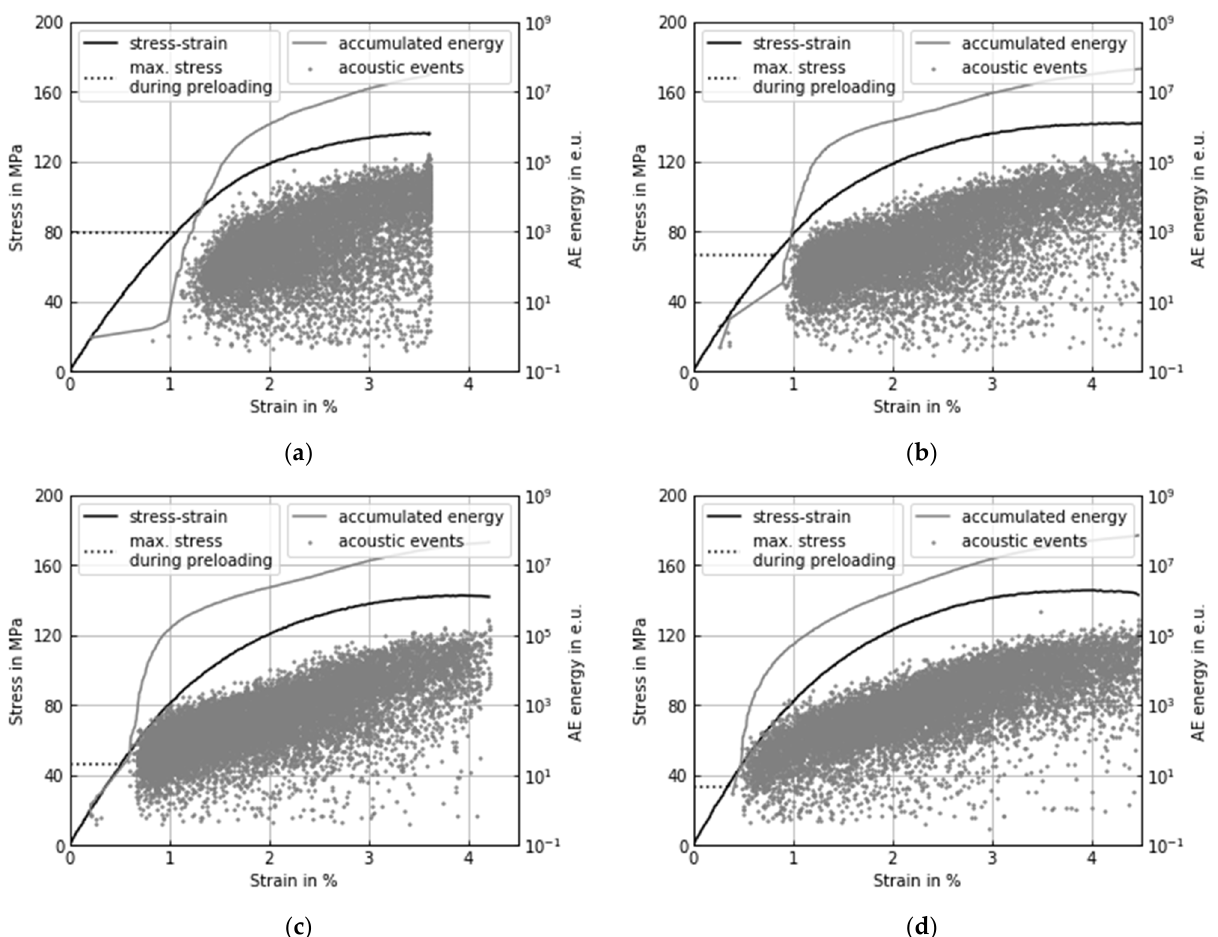
Figure 4. Stress–strain curve, acoustic energy and accumulated acoustic energy in energy units (1 e.u. ≙ 1×10 −21 J) of preloaded specimens: σ max = ( a ) 79.8 MPa; ( b ) 66.5 MPa; ( c ) 46.6 MPa; ( d ) 33.3 MPa.